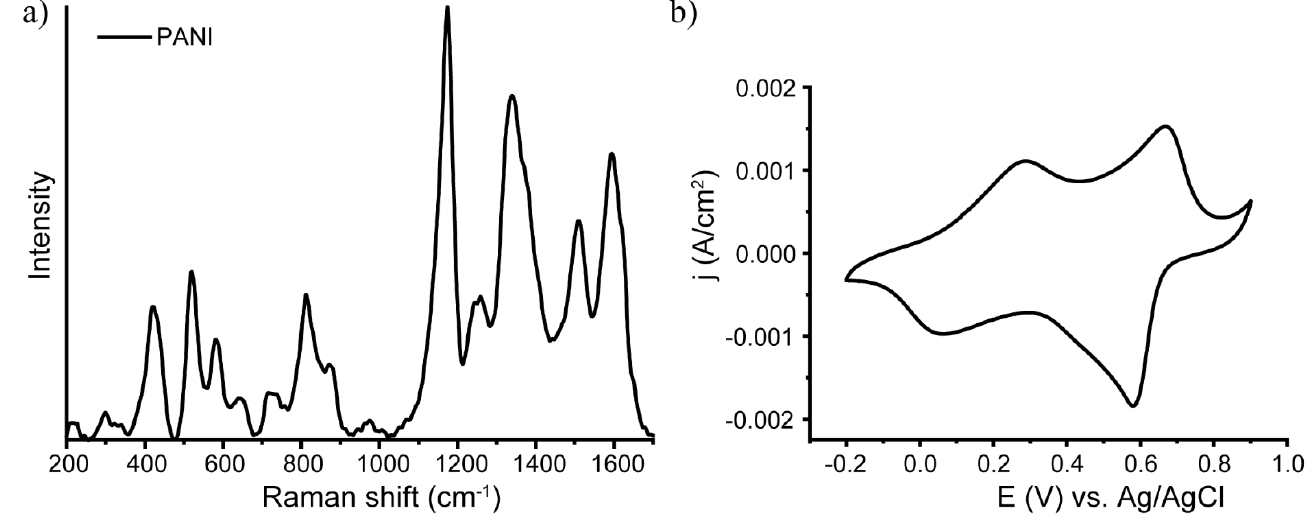
Figure 1. Characterization of the PANI synthesized by in situ polymerization: ( a ) Raman spectra; ( b ) cyclic voltammetry.